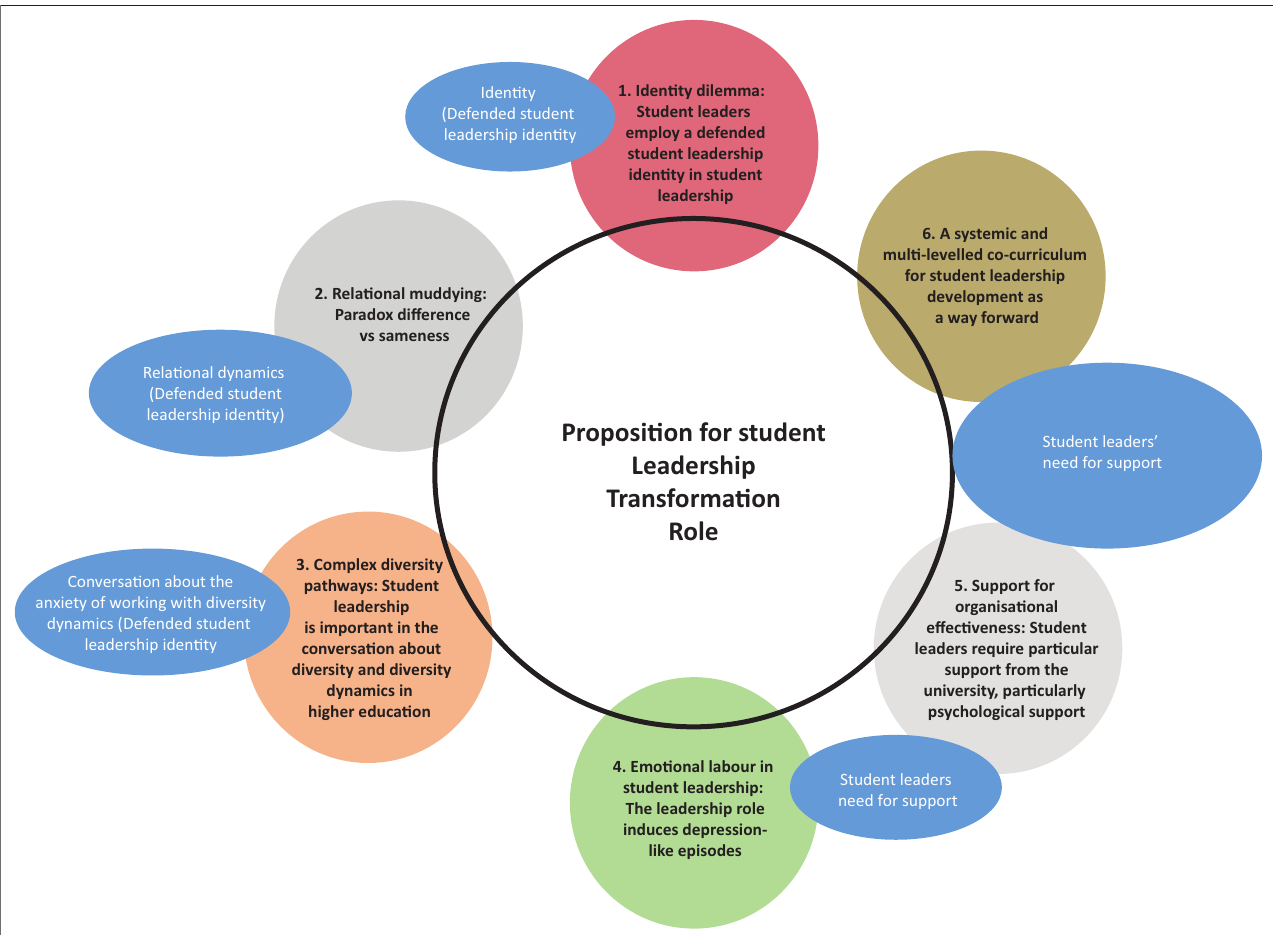
FIGURE 4: Integrated themes and propositions for the student leadership transformation